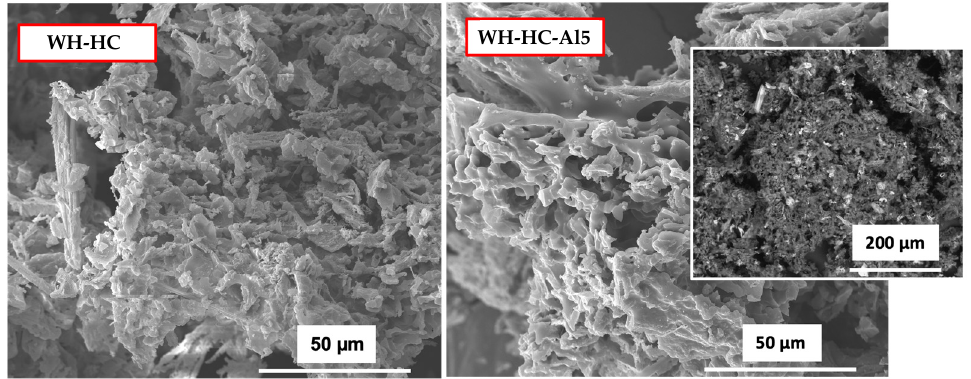
Figure 4. SEM micrographs of uncatalyzed HC and WH-HC-Al5. Embebed image on the right is a retro-dispersed electron image of WH-HC-Al5.